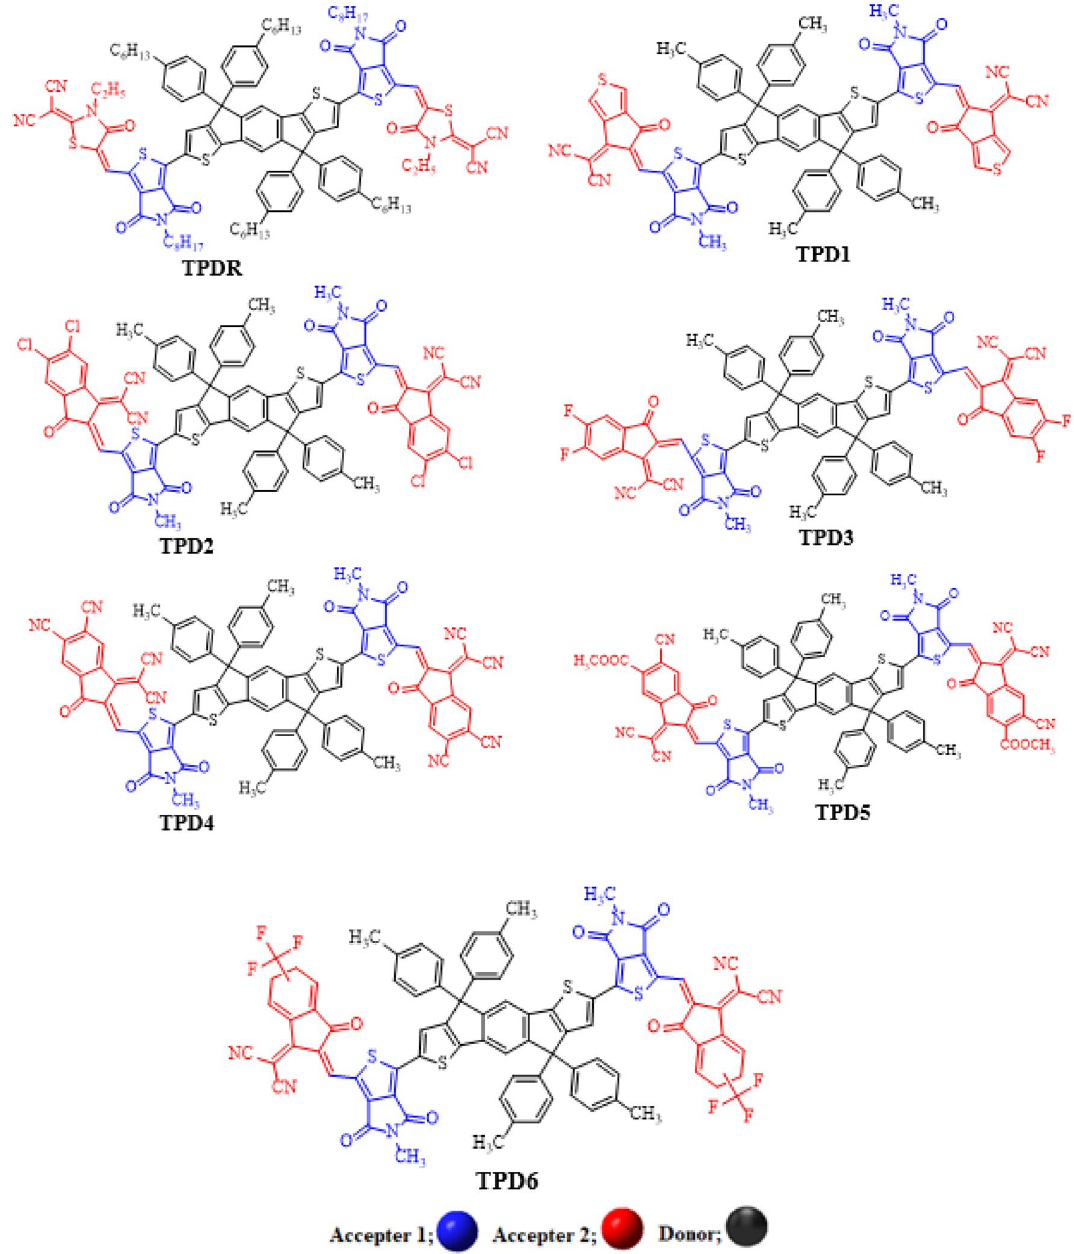
Figure 2. The 2D-structures of entitled compounds for clear view. 2,2 ′ -((5Z,5 ′ Z)-(((4,4,9,9-tetra-p-tolyl-4,9- dihydro-s-indaceno[1,2-b:5,6-b ′ ]dithiophene-2,7-diyl)bis(5-methyl-4,6-dioxo-5,6-dihydro-4H-thieno[3,4-c] pyrrole-3,1diyl))bis (methaneylylidene))bis(6-oxo-5,6-dihydro-4H-cyclopenta[c]thiophene-5,4-diyli idene)) dimalononitrile ( TPD1 ), 2,2 ′ -((2Z,2 ′ Z)-(((4,4,9,9-tetra-p-tolyl-4,9-dihydro-s-indaceno[1,2-b:5,6-b ′ ]dithiophene- 2,7-diyl)bis(5-methyl-4,6-dioxo-5,6-dihydro-4H-thieno[3,4-c]pyrrole-3,1-diyl) )bis(methaneyly-lidene)) bis(5,6-dichloro-3-oxo-2,3-dihydro-1H-indene-2,1-diylidene))dimalono- nitrile ( TPD2 ), 2,2 ′ -((2Z,2 ′ Z)-(((4,4,9,9- tetra-p-tolyl-4,9-dihydro-s-indaceno[1,2-b:5,6-b ′ ]dithio phene-2,7-diyl)bis(5-methyl-4,6-dioxo-5,6-dihydro- 4H-thieno[3,4-c]pyrrole-3,1-diyl))bis(methane ylylidene))bis(5,6-difluoro-3-oxo-2,3-dihydro-1H-indene-2,1- diylidene))dimalononitrile ( TPD3 ), (2Z,2 ′ Z)-2,2 ′ -(((4,4,9,9-tetra-p-tolyl-4,9-dihydro-s-indaceno[1,2-b:5,6-b ′ ] dithiophene-2,7-diyl)bis(5-methyl-4,6-dioxo-5,6-dihydro-4H-thieno[3,4-c]pyrrole-3,1-diyl))bis(methaneylylidene)) bis(1-(dicyanomethyl ene)-3-oxo-2,3-dihydro-1H-indene-5,6-dicarbonitrile) ( TPD4 ), methyl (Z)-6-cyano-2-((3-(7- (3-(((Z)-5-cyano-1-(dicyanomethylene)-6-(methoxycarbonyl)-3-oxo-1,3-dihydro-2H-inden-2-ylidene)methyl)-5- methyl-4,6-dioxo-5,6-dihydro-4H-thieno[3,4-c]pyrrol-1-yl)-4,4,9,9-tetra-p-tolyl-4,9-dihydro-s-indaceno[1,2-b:5,6-b ′ ] dithiophen-2-yl)-5-methyl-4,6-dioxo-5,6-dihydro-4H-thieno[3,4-c]pyrrol-1-yl)methylene)-1-(dicyanomethylene)- 3-oxo-2,3-dihydro-1H-indene-5-carboxylate ( TPD5 ) and 2,2 ′ -((2Z,2 ′ Z)-(((4,4,9,9-tetra-p-tolyl-4,9-dihydro-s- indaceno[1,2-b:5,6-b ′ ]dithiophene-2,7-diyl)bis(5-methyl-4,6-dioxo-5,6-dihydro-4H-thieno[3,4-c]pyrrole-3,1-diyl)) bis(methaneylylidene))bis(3-oxo-2,3,5,6-tetrahydro-1H-indene-2,1-diylidene))dimalononitrile ( TPD6